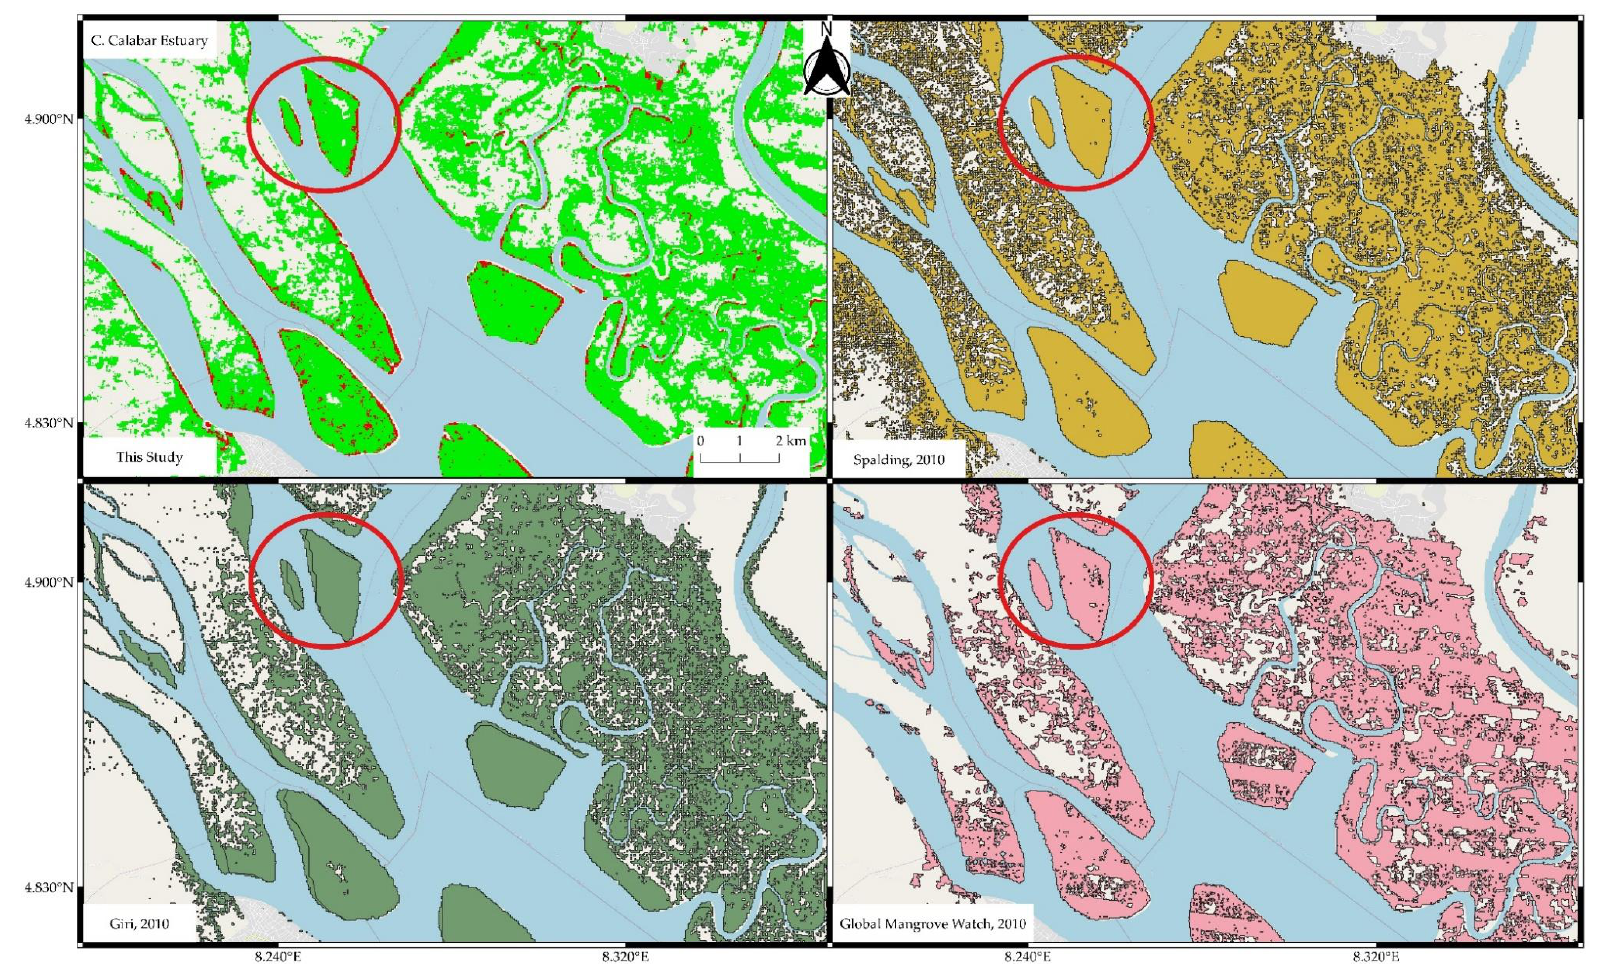
Figure 8. Comparison of di ff erent mangrove maps with red circles showing similarities and black circles showing underestimation. ( A ) Oproama creek; ( B ) Benin river estuary; and ( C ) Calabar estuary showing Nipa Palm cover on Alligator Island compared with global maps.